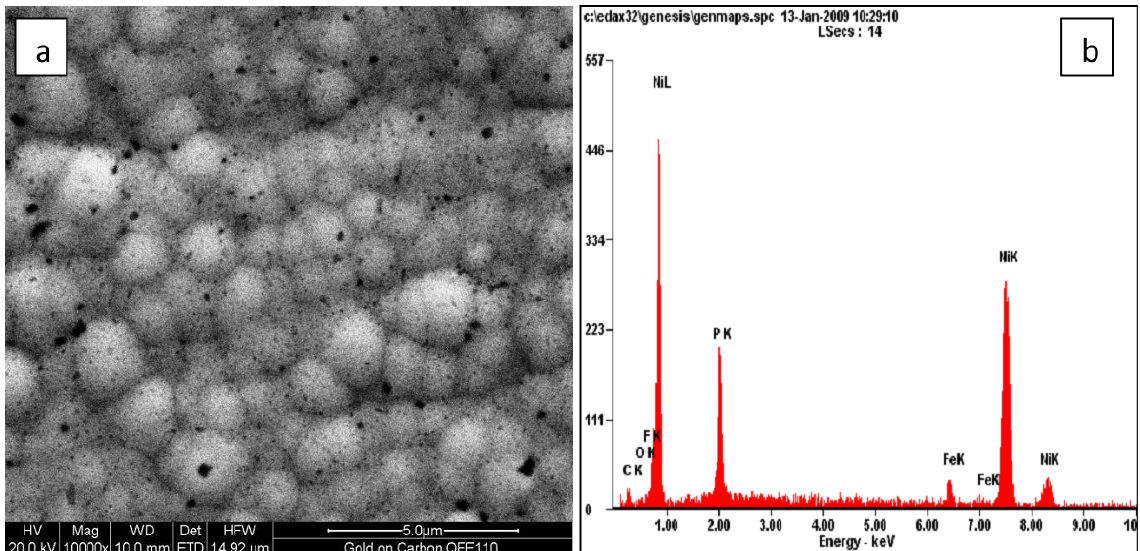
Figure 2. (a) SEM micrograph and (b) EDAX analysis of Ni-P-PTFE coating on mild steel substrates.